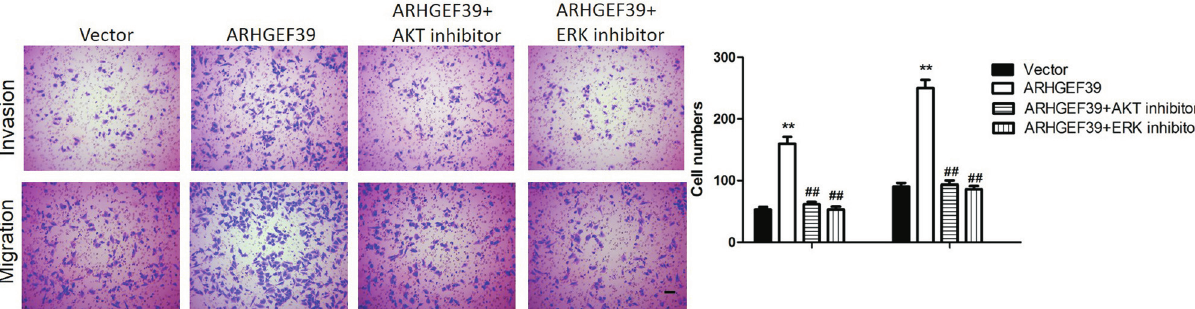
Figure 6 - The promoting effect of ARHGEF39 on the migration and invasion was reversed by blocking the activation of AKT and ERK. LY294002, an inhibitor of AKT, was used to block the activation of AKT. PD98059, an inhibitor of ERK, was used to block the activation of ERK. **p<0.01 vs. vector group. ##p<0.01 vs. ARHGEF39